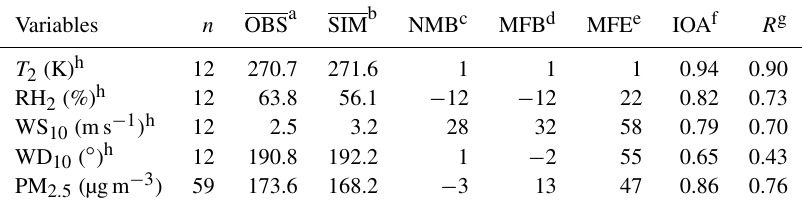
Table 3. Statistical metrics between observations and simulations.